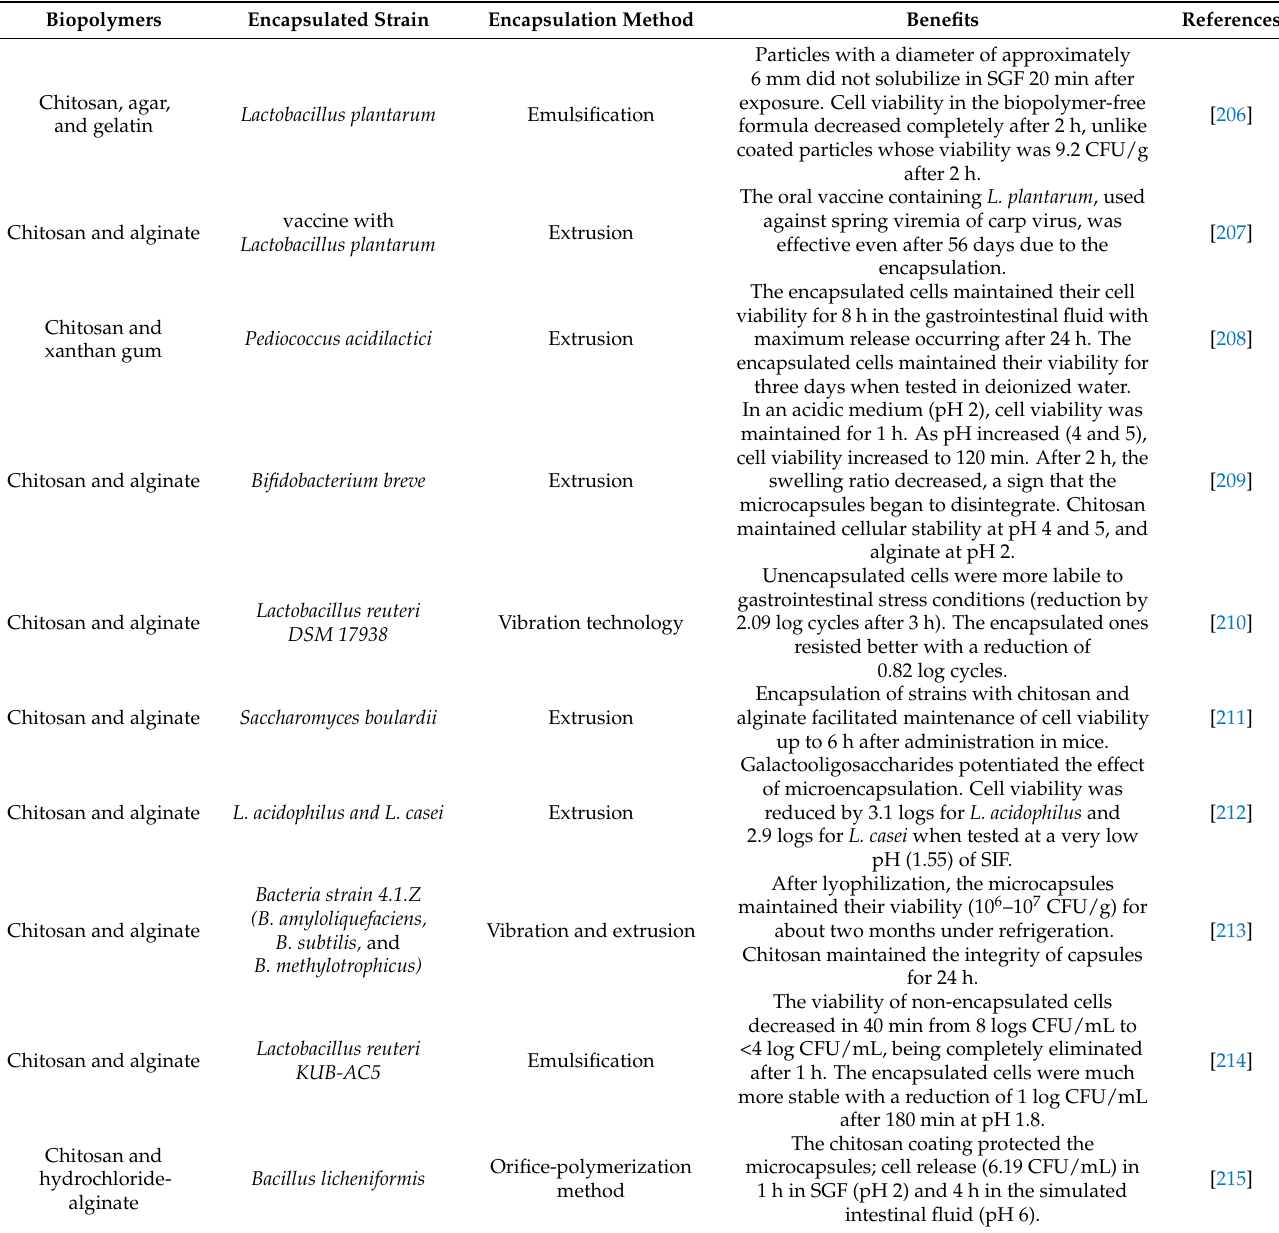
Table 6. Chitosan use for probiotic